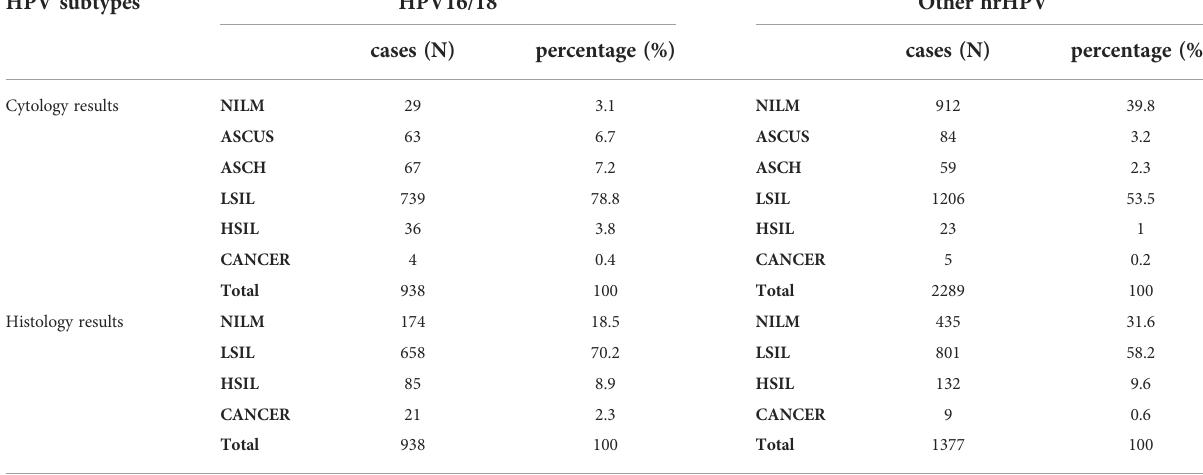
TABLE 5 Cytology and histology results in HPV positives women in